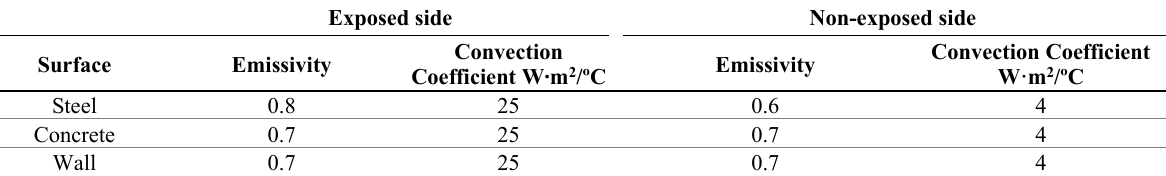
Table 2. Parameters adopted for calibration of the thermal numerical model. Exposed side Non-exposed side